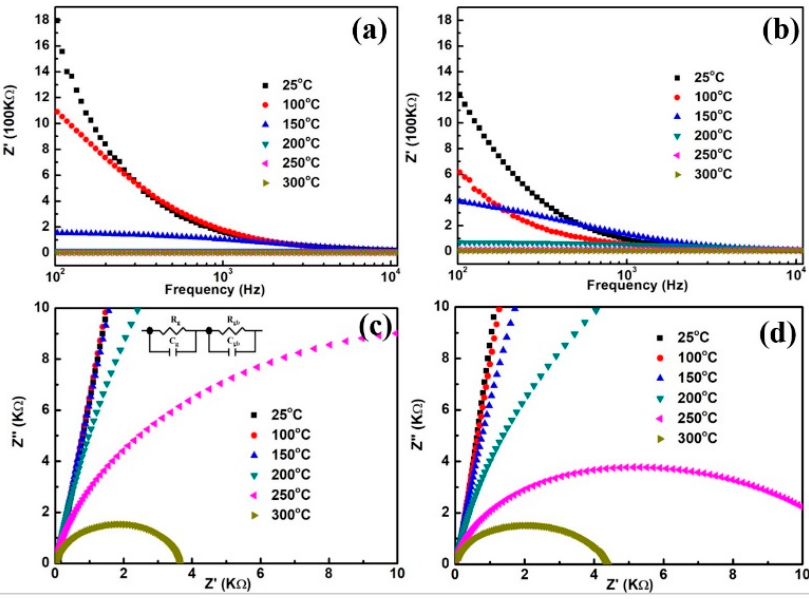
Figure 5. The real part (Z’) versus frequency ( a , b ) and complex impedance plots ( c , d ) for undoped CCTO ( a , c ) and Zn-doped CCTO ( c , d ), respectively, with a measured temperature of 25–300 °C. Inset in ( c ) shows the two parallel RC equivalent circuits in series.